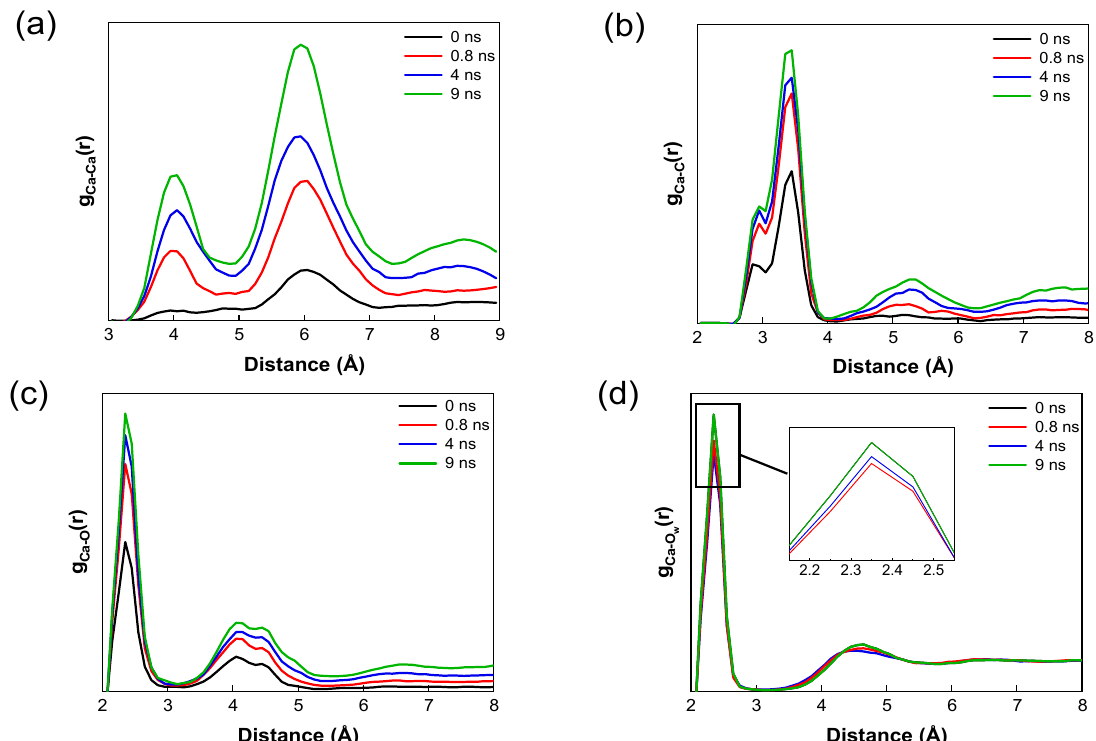
Figure 1. Radial distribution functions (RDFs) for ( a ) Ca-Ca, ( b ) Ca-C, ( c ) Ca-O, and ( d ) Ca-O w in 0.96 mol/L CaCO 3 solution at 360 K. Here, O and O w refer to oxygens in the carbonate and water, respectively.